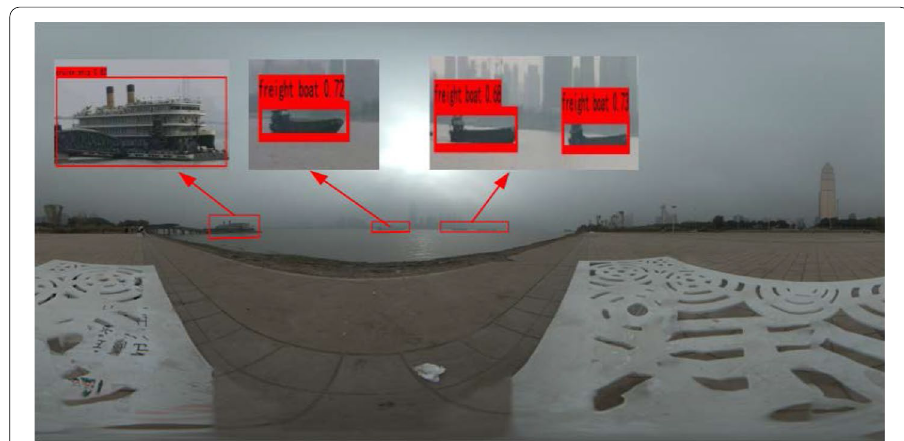
Fig.10 Detection result of panoramic visual